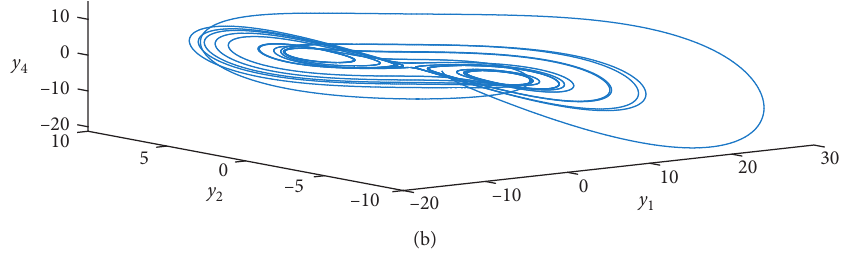
Figure 11: The phase portrait of master subsystem and the slave subsystem.